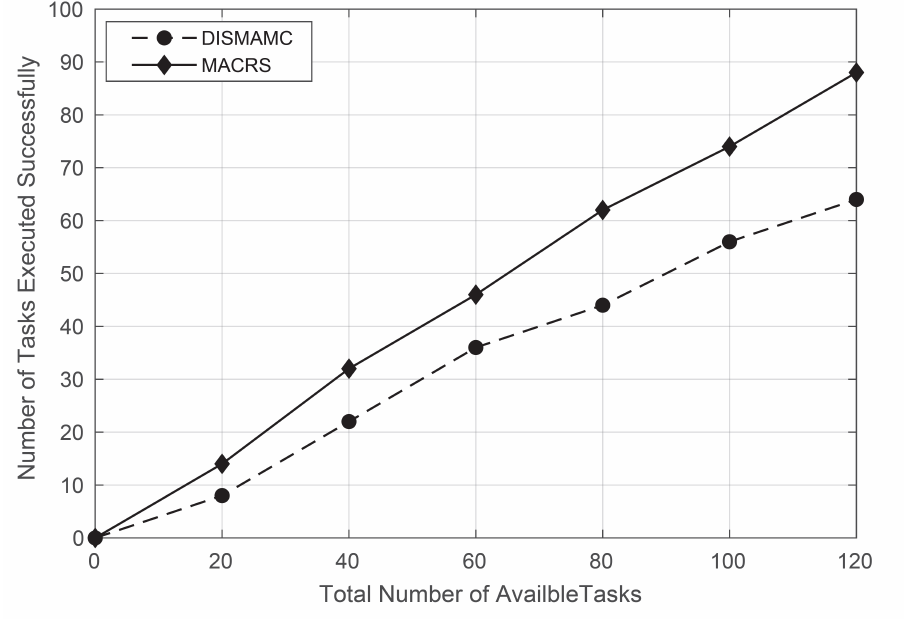
Figure 18. Success rate of